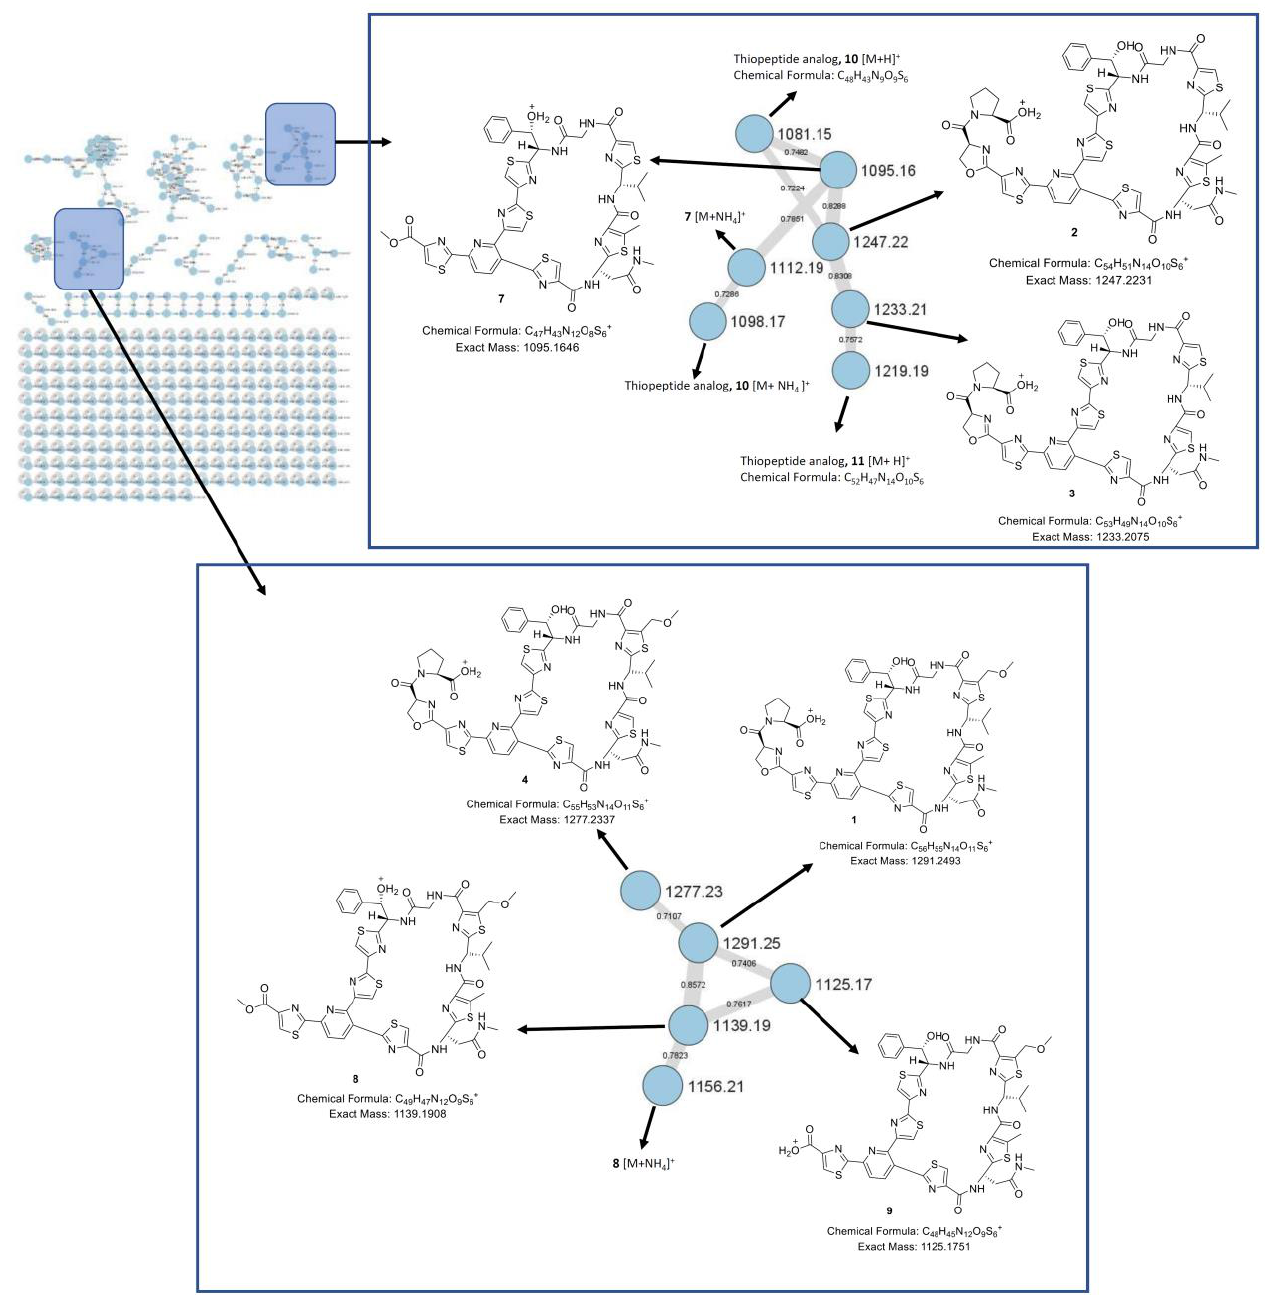
Figure 2. GNPS molecular networking of the crude extract of Nonomuraea jiangxiensis and the structures attributed to nodes in the thiopeptide GNPS clusters.